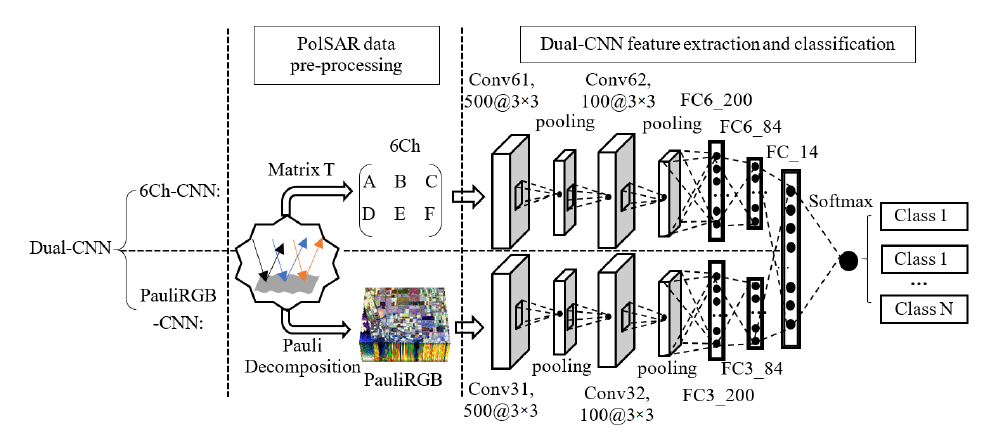
Figure 2. The main procedures of the polarimetric synthetic aperture radar (PolSAR) images classification based on the dual-branch deep convolution neural network (Dual-CNN)